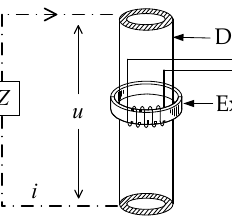
Figure 7. Equivalent circuit of the measurement path of the logging instrument.